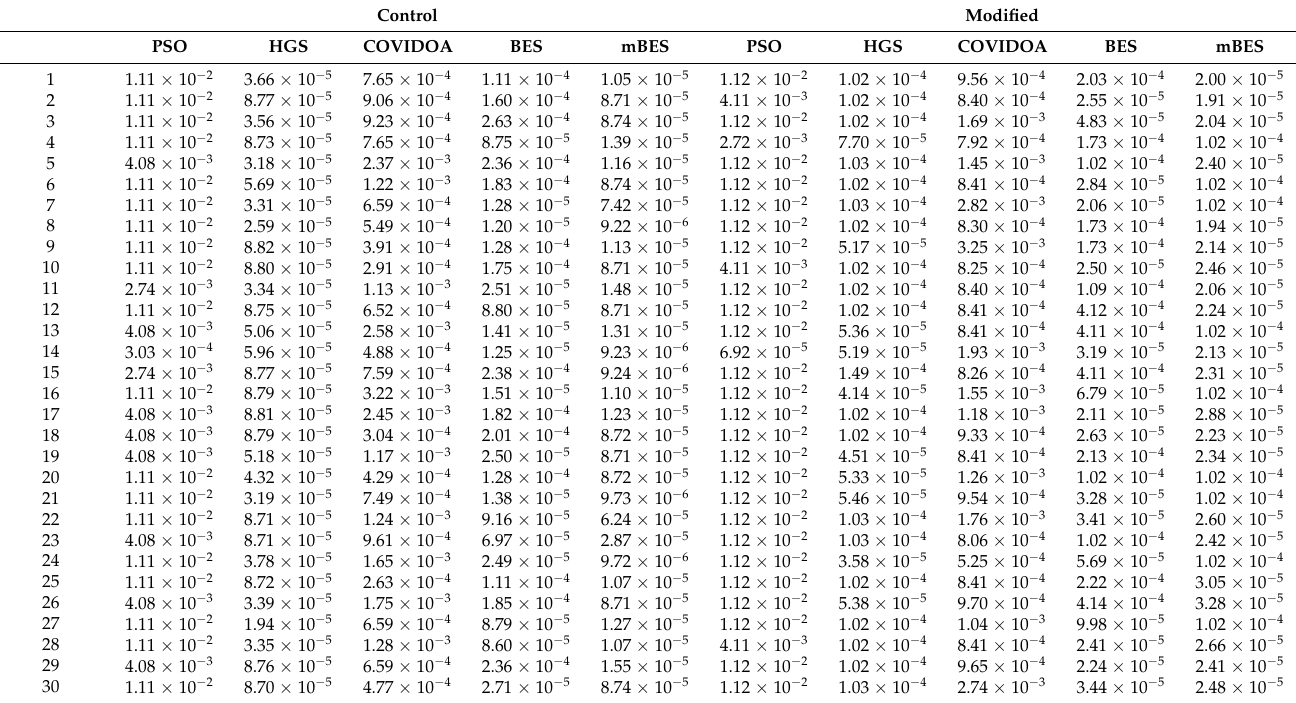
Table 4. Details of 30 runs applying different algorithms.